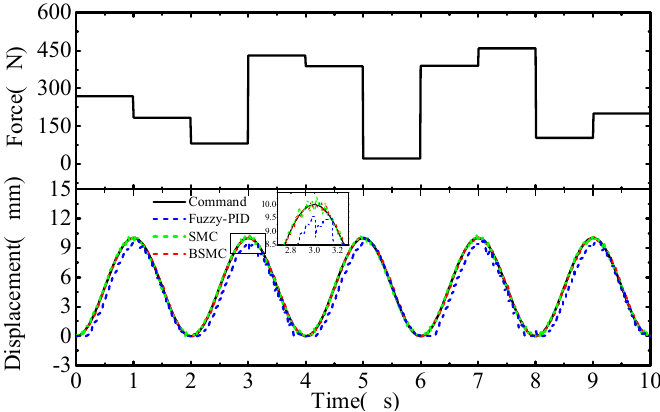
Figure 7. Sine response of the cylinder under random step load. Figure 10 shows the tracking error of the sinusoidal response of the hydraulic cylin- der under random load. The maximum tracking error of the system under fuzzy PID con- trol can reach 1.5 mm and the load fluctuation range is large. The error fluctuation range under backstepping sliding-mode control is small, which indicates the good tracking per- formance of the hydraulic cylinder.